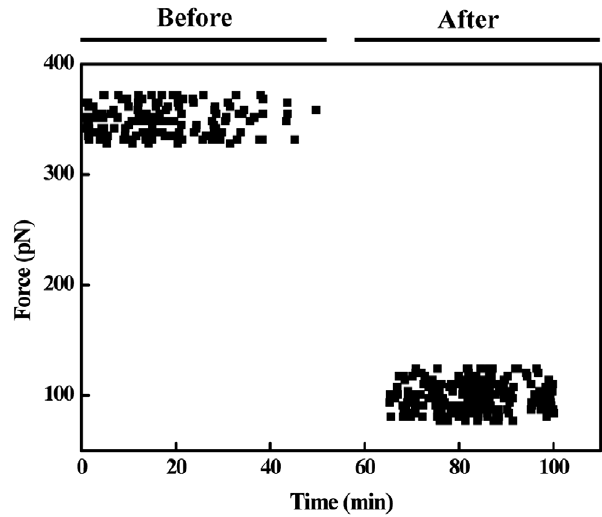
Figure 4. The AFM measurement of the molecular forces associated with EBO 16 -DRM interactions. Force distributions over time before and after the system was saturated with 1 mM wtEBO 16 . All experiments were done in phosphate buffer at room temperature.